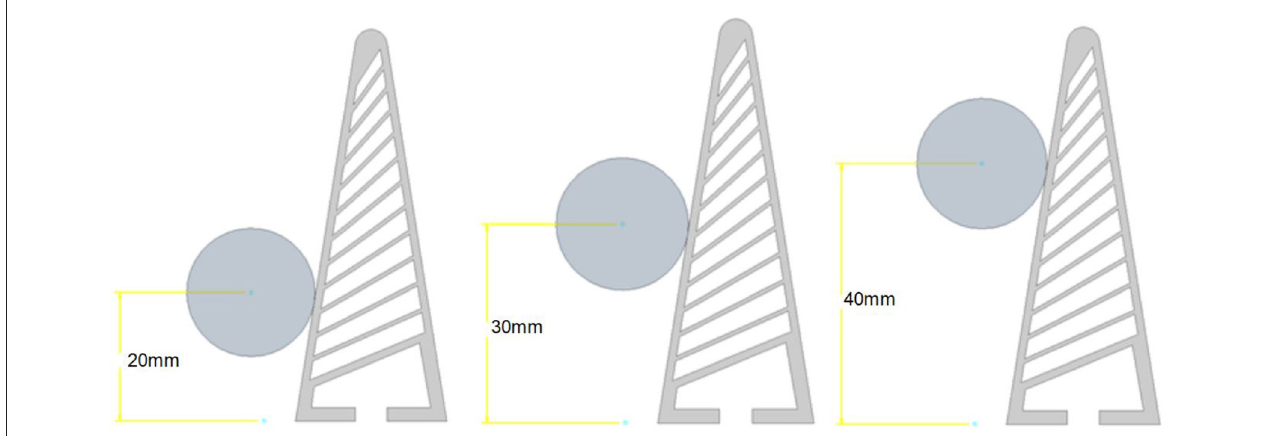
FIGURE 3 | Object height increments. We capture the variations in point of contact by explicitly generating training simulations for object contacts at three different heights representing contact forces at low, mid, and high